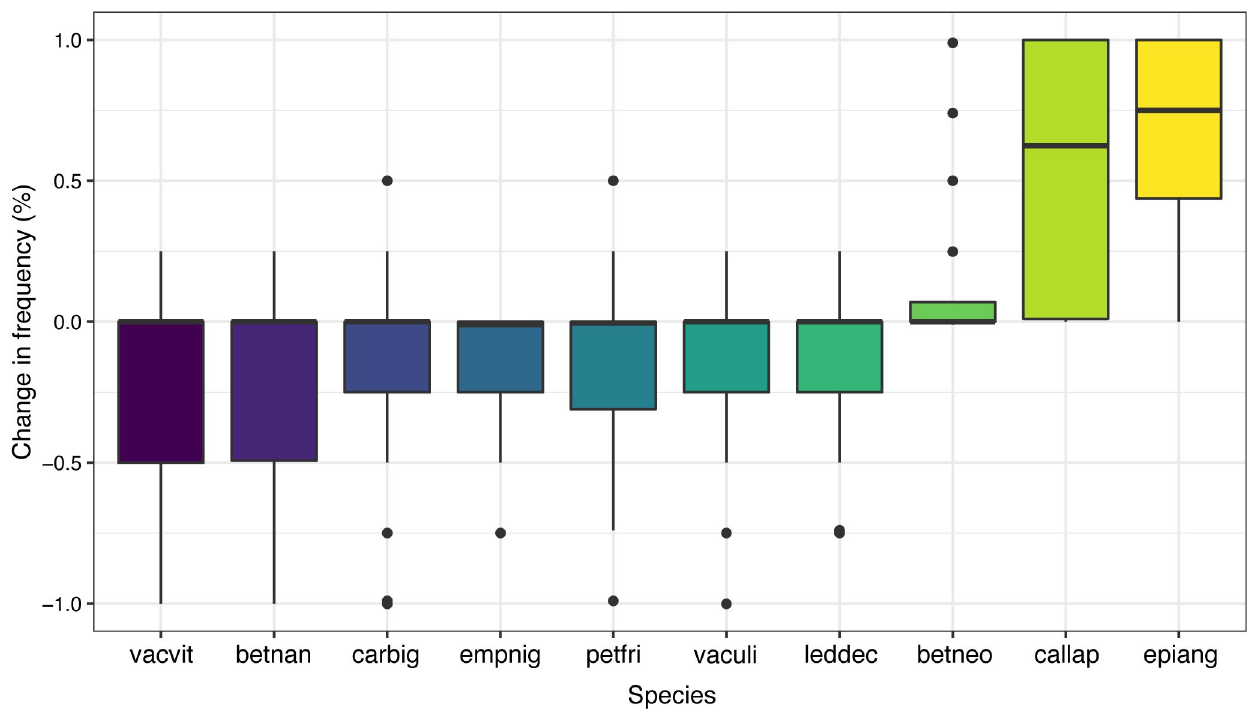
Fig 7. Box and whiskers plot of the change in frequency of occurrence at sites pre to post-fire for the ten vascular plant species contributing the largest absolute average difference. Species codes are the first three letters of genus and species for Vaccinium vitis-idaea , Betula nana , Carex bigelowii , Empetrum nigrum , Petasites frigidus , V . uliginosum , Rhododendron tomentosum subsp. decumbens , B . neoalaskana , Calamagrostis laponica , and Chamerion angustifolium .